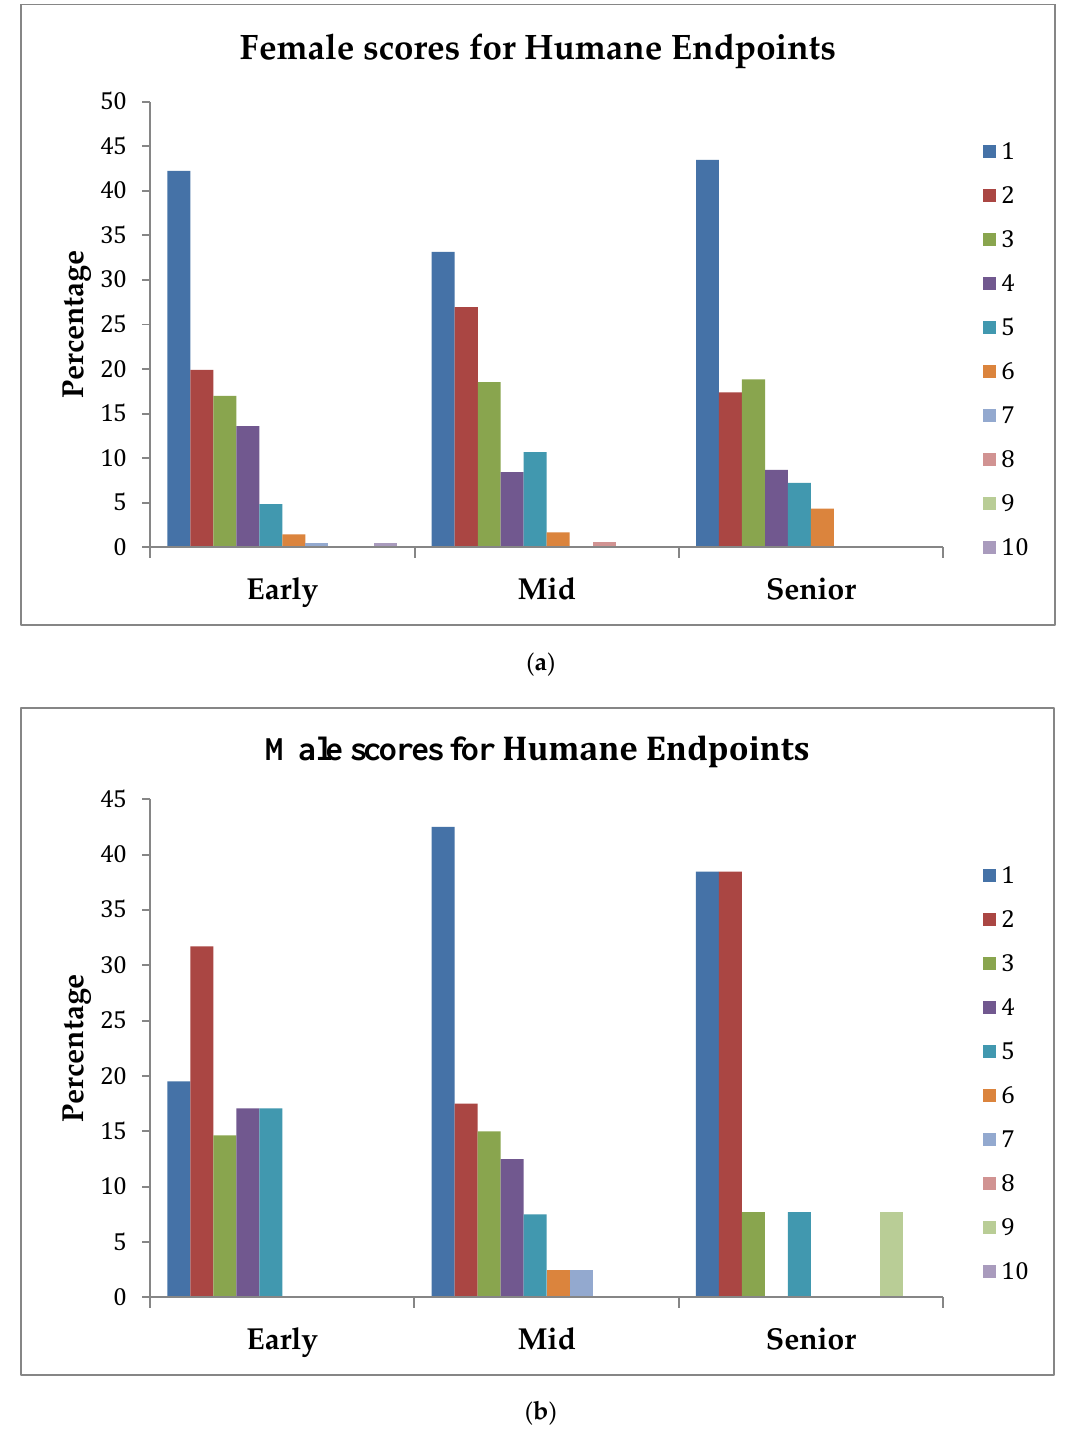
Figure 1. ( a ) Percentage of female students across stage-of-study rating the importance (1 = extremely important, 10 = least important) of an understanding of Humane Endpoints on their first day in practice; ( b ) percentage of male students across stage-of-study rating the importance (1 = extremely important, 10 = least important) of an understanding of Humane Endpoints on their first day in practice.